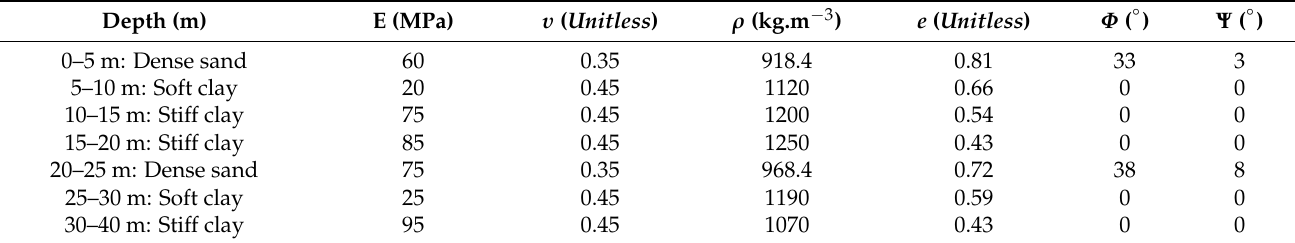
Table 4. The properties for the soil layers.